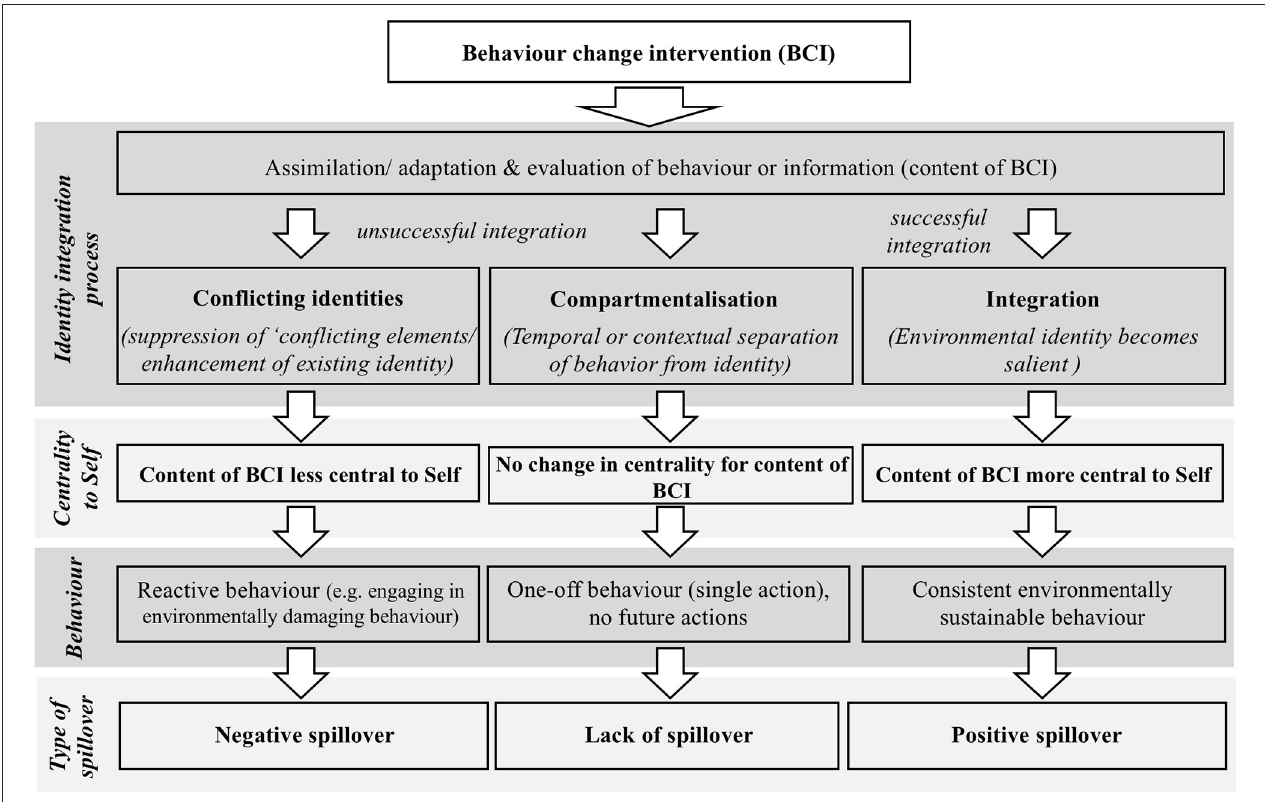
FIGURE 1 | Conceptual framework for understanding